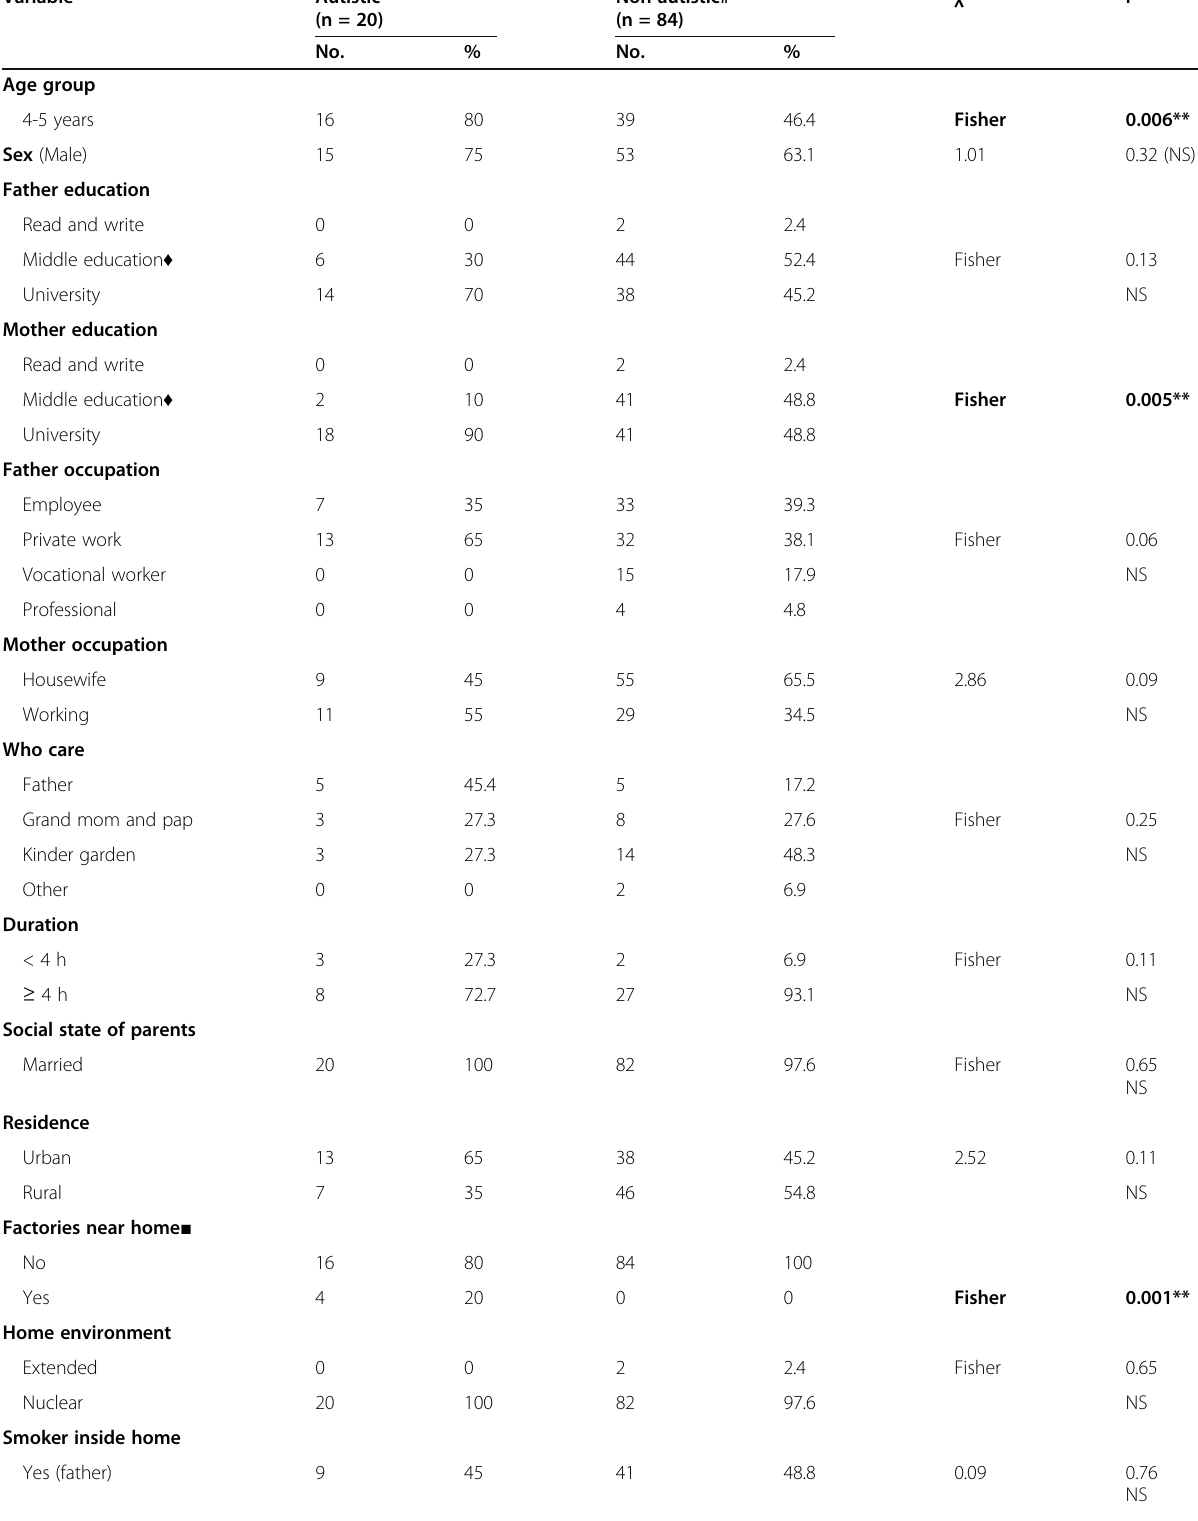
Table 2 Comparison between autistic and non-autistic children in demographic data